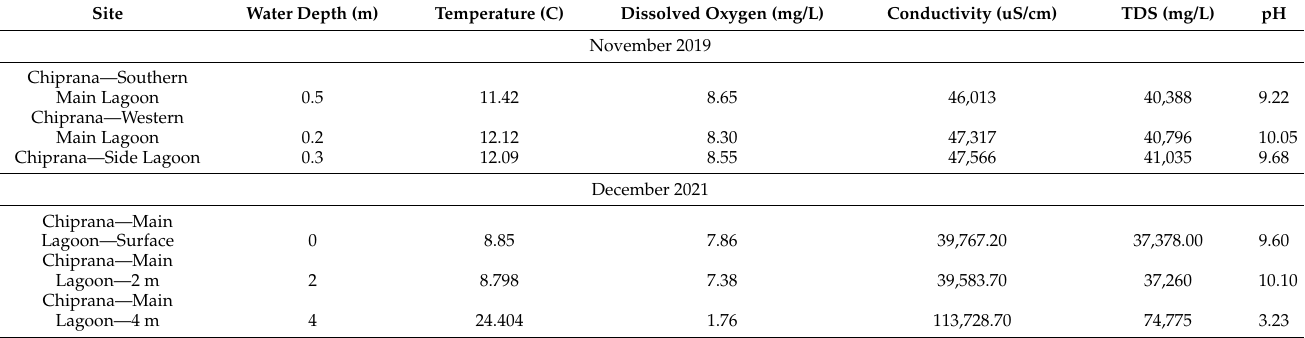
Table 1. Limnological characteristics of Laguna Salada de Chiprana at the lake surface during November 2019 and at both the lake surface and approximately 4 m depth during December 2021. Limnological data are from a YSI Exo1 multiparameter